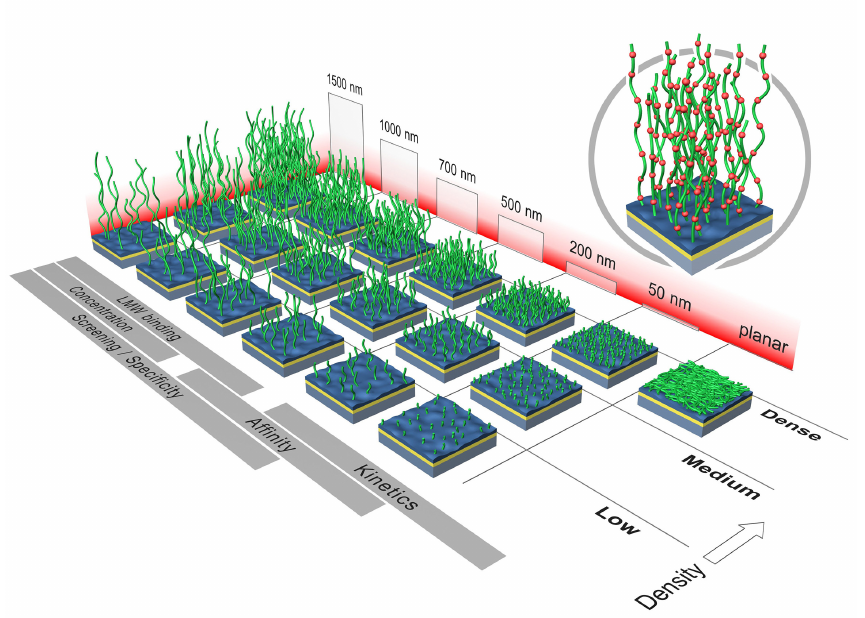
Figure 1. SPR chips commercially available from Xantec, Inc. [22] (© Xantec 2021, all rights